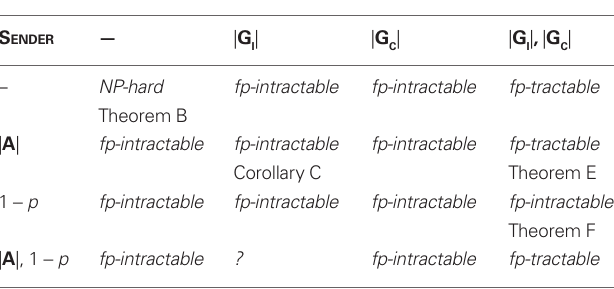
Table A2 | Complexity results for S ender